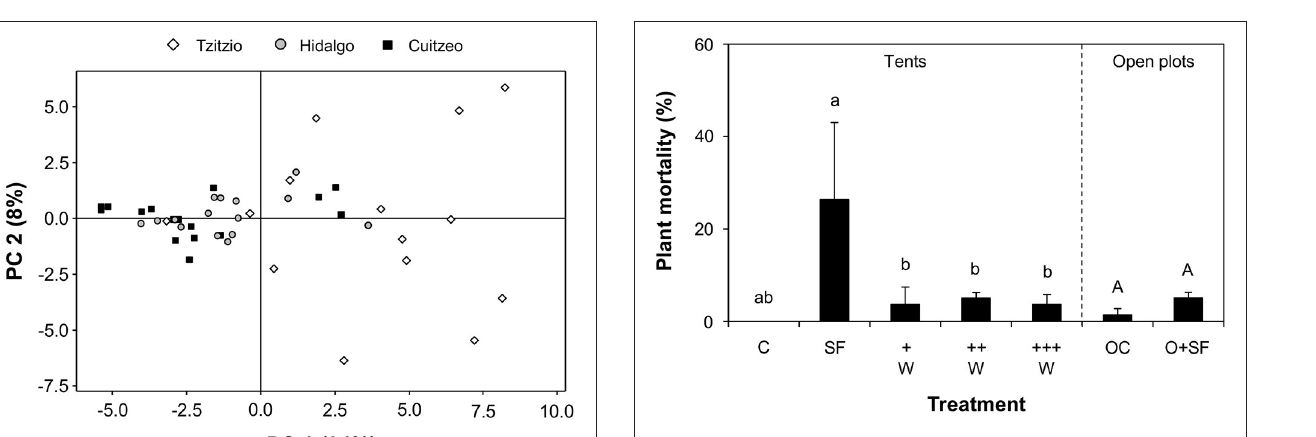
FIGURE 5 | Plant mortality. Shown is the average number of teosinte plants that died before the end of the experiment ( + SE) in plots that were initially covered with tents that were not infested with herbivores (treatment C) or that were infested with larvae in the absence (SF) and in the presence of increasing densities of Campoletis sonorensis parasitoid wasps ( + W, ++ W, + + + W), and in open plots, never covered by a tent (OC, O + SF). Different letters indicate statistically significant differences (GLM, P < 0.05). Lowercase letters represent significant differences between plots initially covered with tents. Uppercase letters represent significant differences between open